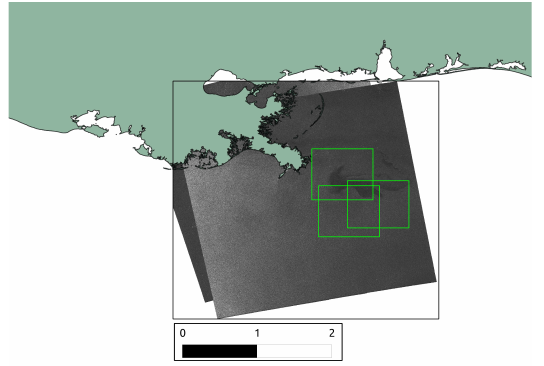
Figure 3: The black-box shows our designated study area. GSHHS shoreline is shown in light green. The SAR intensity images are from Radarsat-2, and the one on top is acquired on April 24th 2010. Light green boxes show the footprints for the ALOS PALSAR imagery. The legend shows distance in degrees.